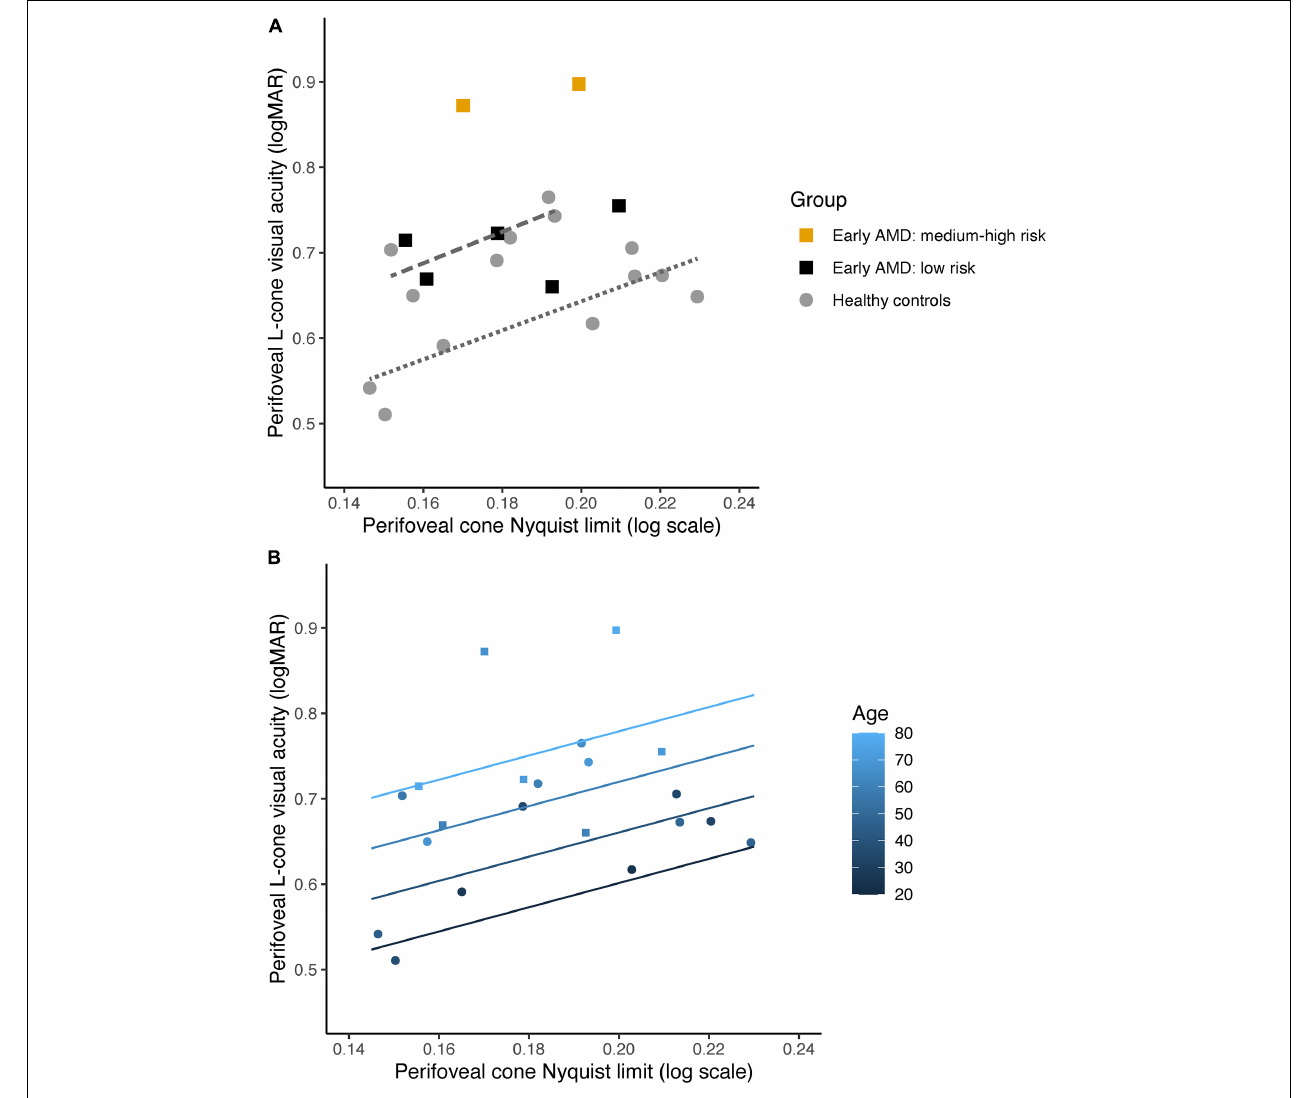
FIGURE 3 | (A) Perifoveal L-cone visual acuity as a function of cone Nyquist sampling limit (N c ) for 14 healthy controls (gray filled circles) and 7 participants with early AMD: 6 with low risk of progression (black filled squares) and 2 with medium or high risk of progression (orange filled squares). Note that data from 5502 is not included in this figure, as we did not obtain AOSLO images of sufficient quality for analysis. Regression lines for log N c and L-cone acuity for the healthy controls aged 50 years and older (dashed line) and younger than 50 years (dotted line), respectively. (B) Predicted regression models for perifoveal L-cone visual acuity as a function of N c at 20, 40, 60, and 80 years of age for healthy controls (filled circles), color coded from dark blue (youngest) to light blue (oldest). Data for the participants with early AMD are also shown (filled